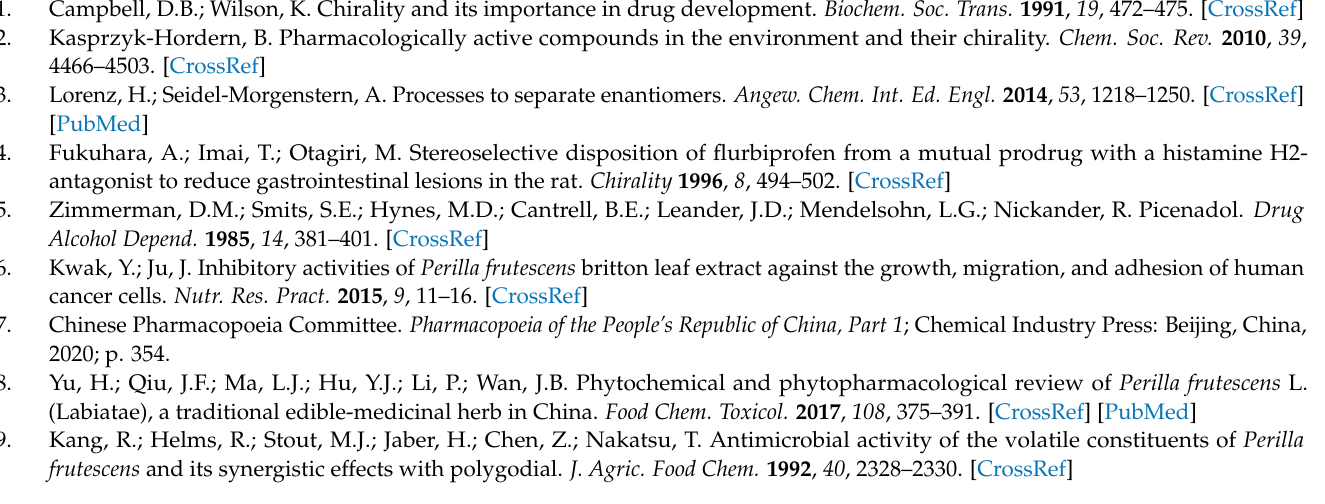
Table S3: the original Western blots in three repetitions for Figure 7 in the